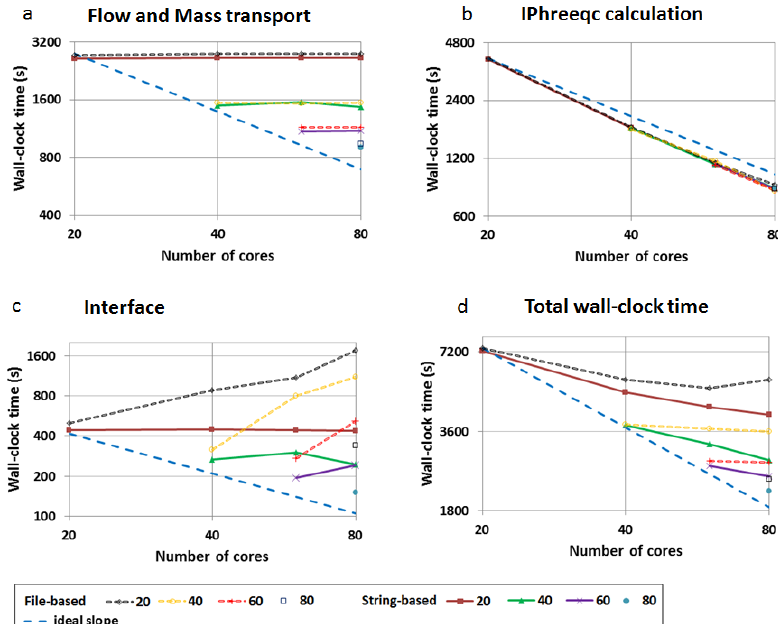
Figure 10. Breakdown of the total wall-clock time in running the 3-D test example on EVE cluster into different processes for different DDCs varying from 20 to 80. (a) Mass transport and flow, (b) geochemical reaction (IPhreeqc), (c) OGS#IPhreeqc interface, and (d) total wall-clock